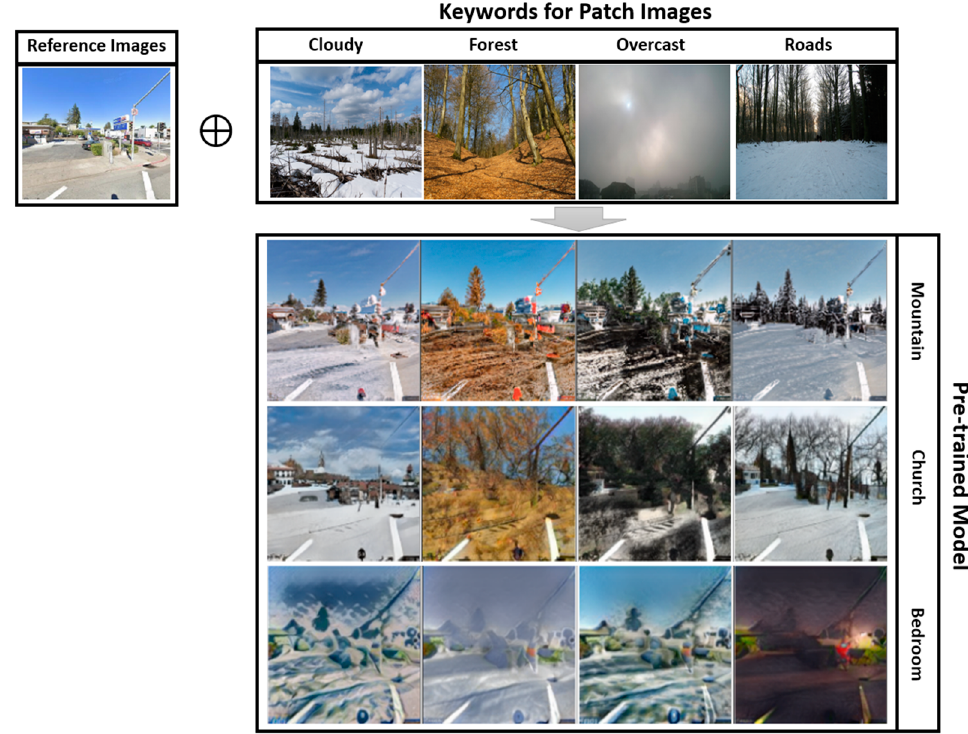
Figure 5. View synthesis performance with the same reference image (first column) on three pre- trained models, i.e., mountain (first row), church (second row), and bedroom (third row). Columns 2–5 represent transfer results from the same set of patch images filtered by keywords “Cloudy”, “Forest”, “Overcast”, and “Roads”, respectively.